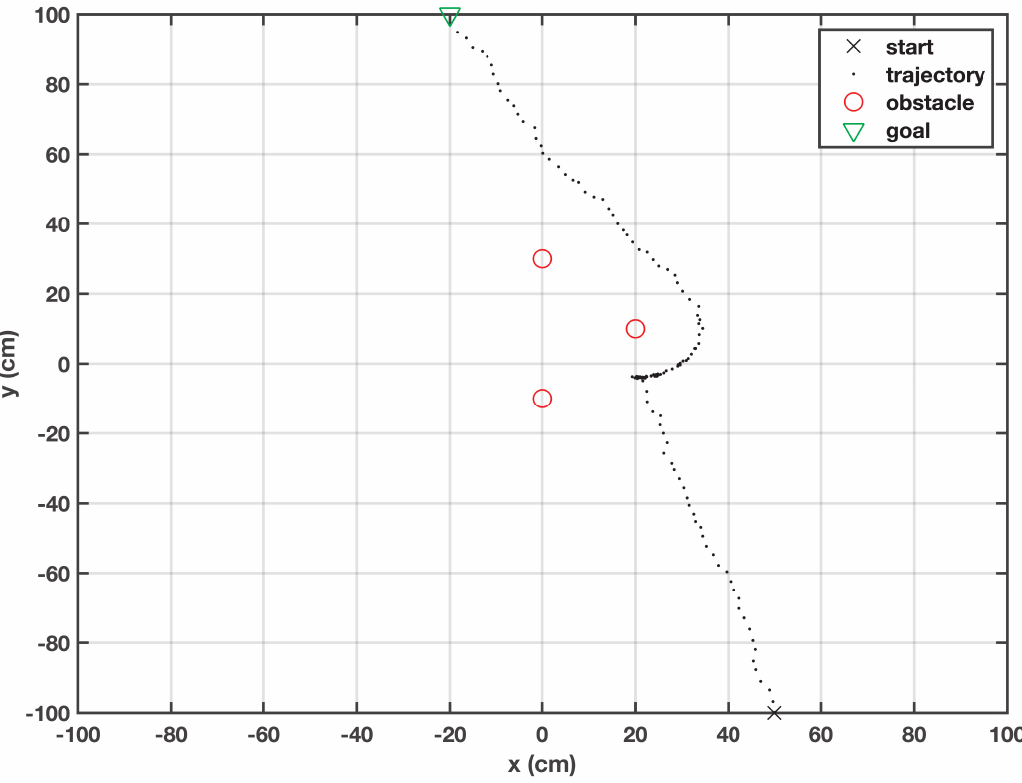
Figure 4. Trajectory of the robot when three obstacles are